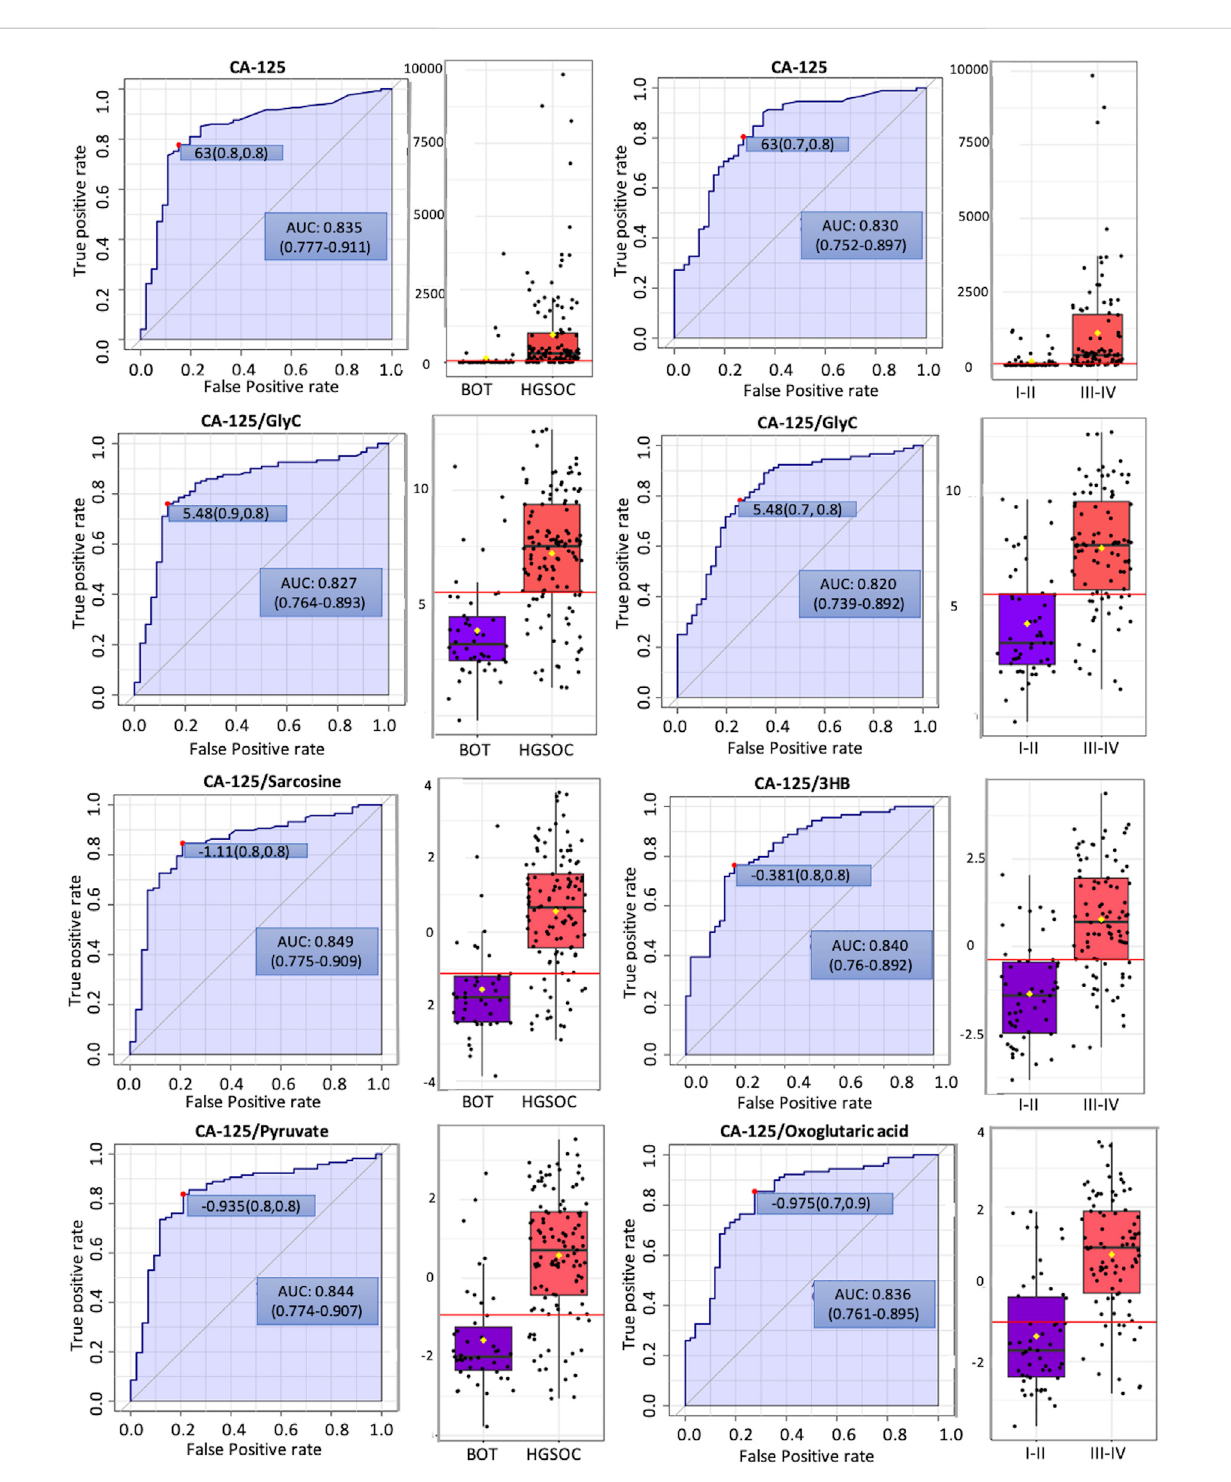
FIGURE 5 Potential biomarker candidates to cancer antigen-125 markers for ovarian cancer diagnosis and prognosis. The optimal cutoff was based on the closest to the top left corner principle and is indicated by the red dot in all the ROC curves. Black dots and yellow diamond represent the level of cancer antigen-125 and each ratio and mean concentration of cancer antigen-125 and each ratio,